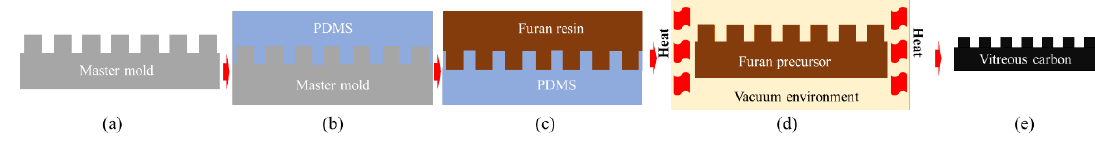
Figure 7. Schematic illustration of the fabrication of a GC mold: ( a ) master mold, ( b ) polydimethylsiloxane (PDMS) casting, ( c ) furan casting, ( d ) carbonization in a vacuum or inert ambient environment, and ( e ) the GC mold.